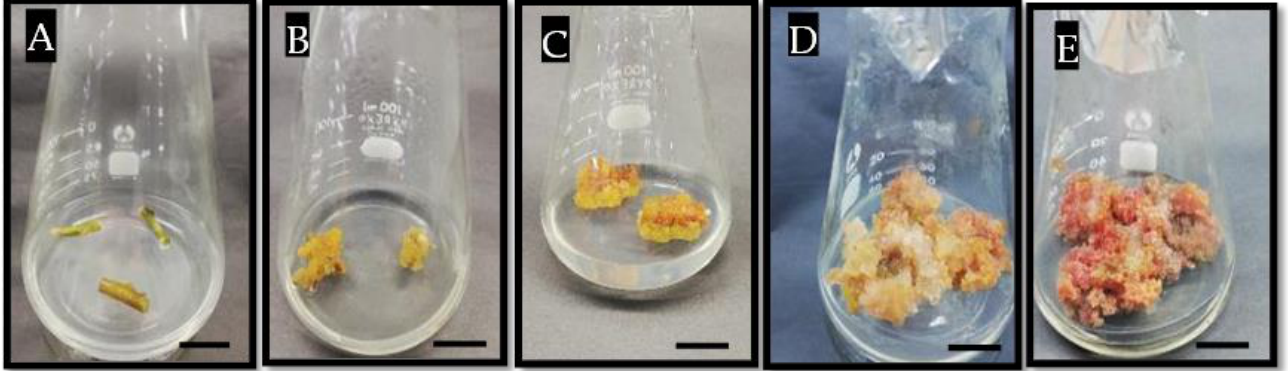
Figure 2. In vitro callus induction of Bougainvillea glabra Choisy under dark incubation condition. ( A ) Sterilized nodal segment on WPM basal medium; ( B ) callus induction from a node section on WPM medium supplemented with 2.5 µM 2,4-D + 1.5 µM BAP after 3 weeks; ( C ) callus after 4 weeks in the same medium and PGRs condition; ( D ) callus after 8 weeks; ( E ) callus induction from a node section on WPM medium fortified with 7.5 µ M 2,4-D + 1.5 µ M BAP after 10 weeks with a red